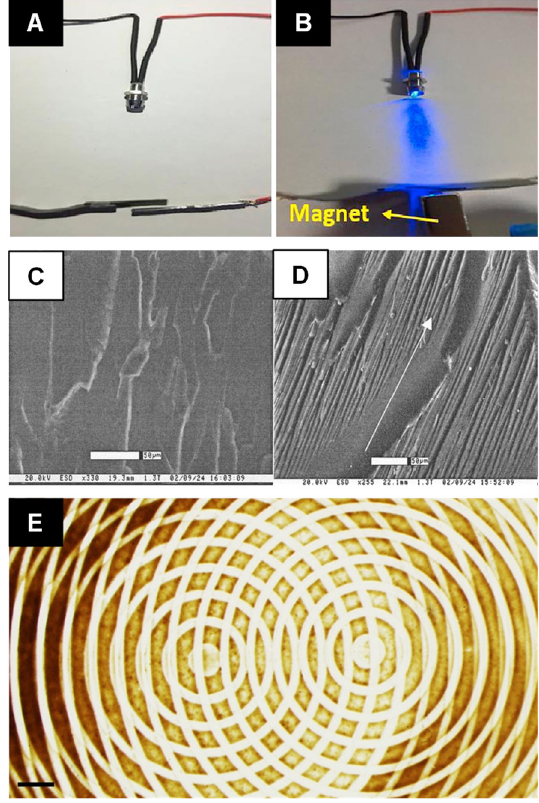
Figure 4. A nanocomposite magnetic switch: ( A ) a gap between an aligned CNT coated composite and a nonmagnetic Pb is ( B ) closed when a magnet is placed underneath the Pb sheet, which lights an LED. Reprinted with permission from [112]. Copyright 2019 Elsevier. Environmental scanning electron microscopy images show the morphology of an epoxy composite sample processed at ( C ) no applied magnetic field and ( D ) at 15 T. The arrow represents the direction of the corresponding magnetic field. Reprinted with permission from [114]. Copyright 2004 John Wiley and Sons. ( E ) A complex pattern formed in a composite by the superposition of two separate magnetic fields. Reprinted with permission from [115]. Copyright 2017 Springer Nature.